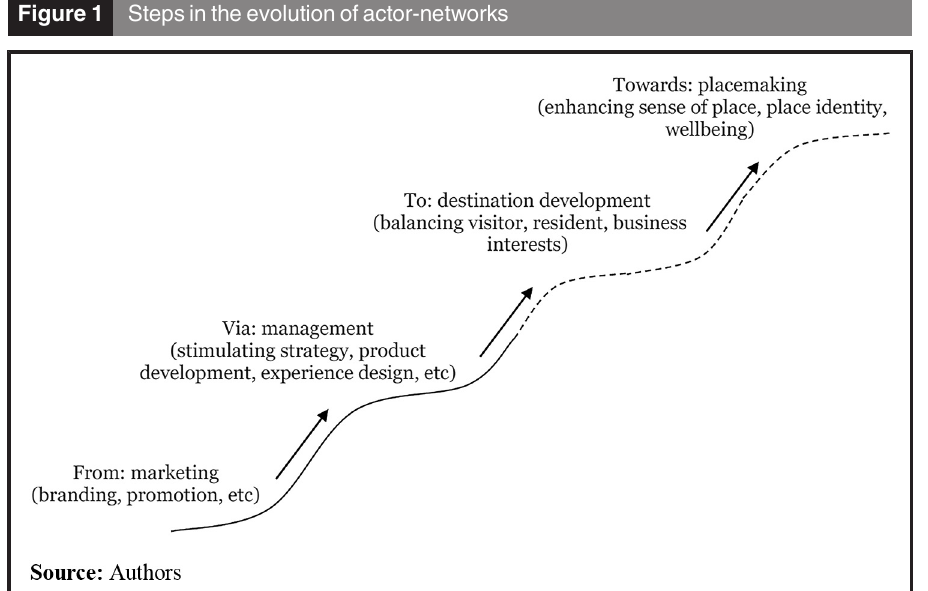
Figure 1 Steps in the evolution of